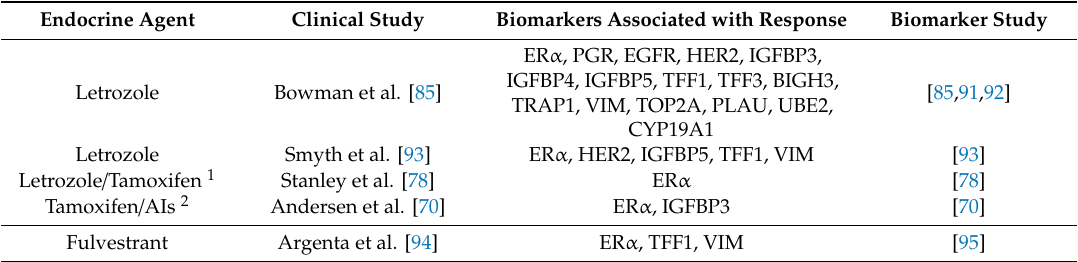
Table 1. Clinical studies of anti-estrogen therapies in ovarian cancer that have linked biomarker expression to clinical